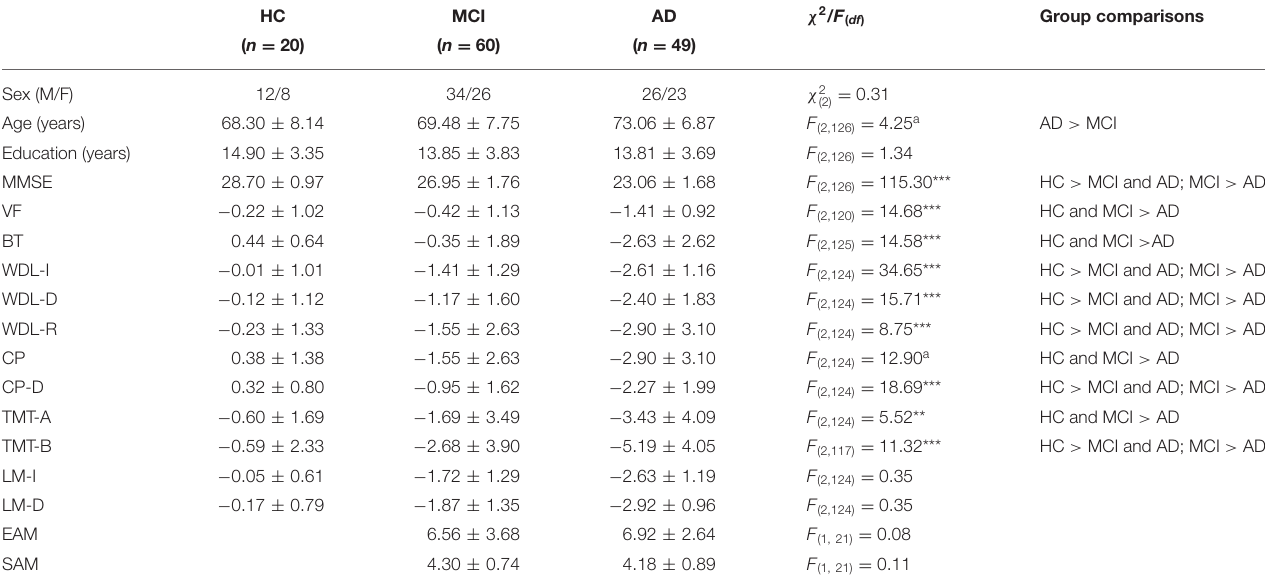
TABLE 1 | Master sample: demographical and clinical